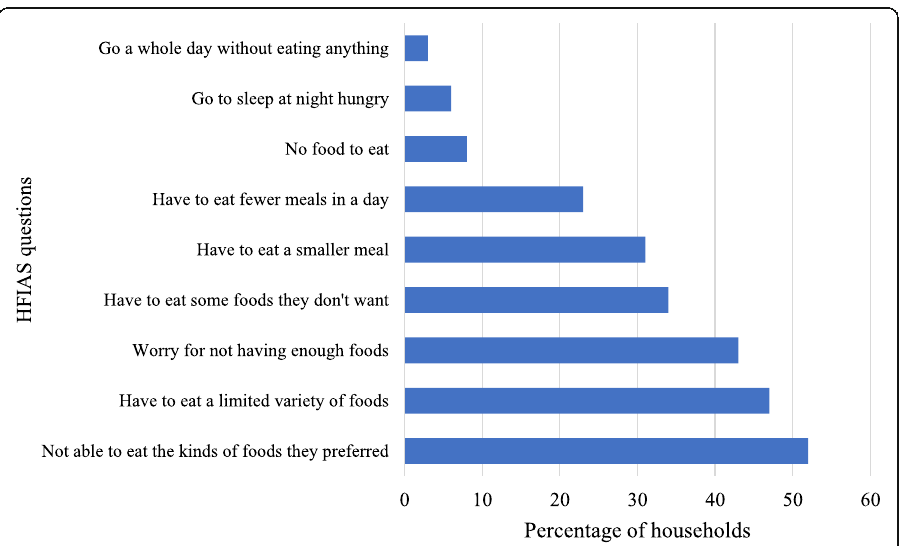
Fig. 4 Distribution of Household Food Insecurity Access Scale (HFIAS) scores. Source: authors ’ calculations using survey